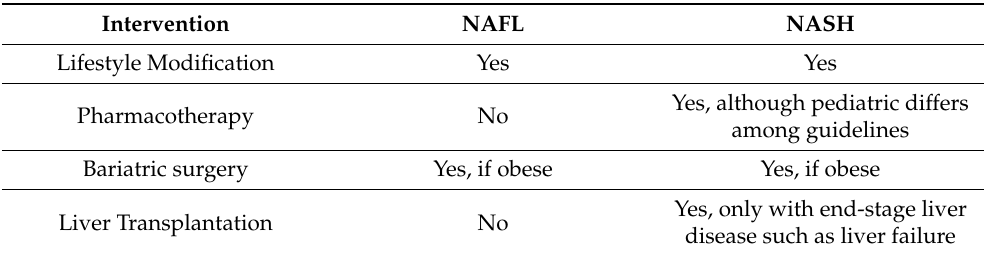
disease such as liver